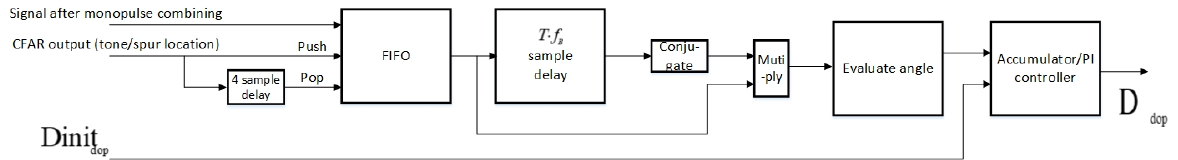
Figure 7. The Doppler estimation module.